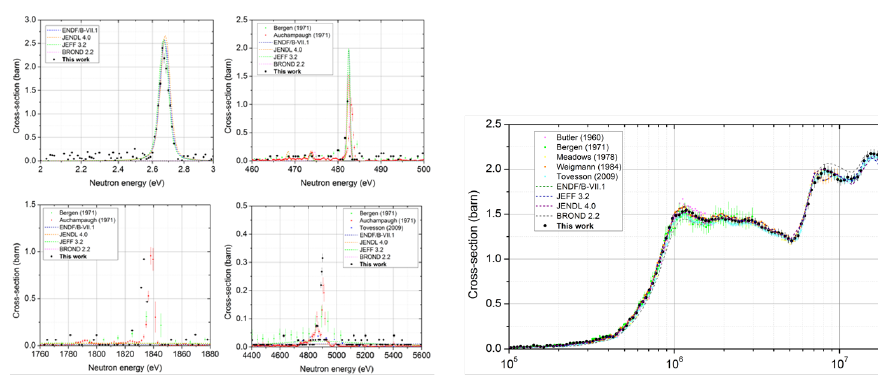
Figure 4: 242 Pu(n,f) cross section in the resonance region (left hand side), and in threshold region (right hand side) [7]